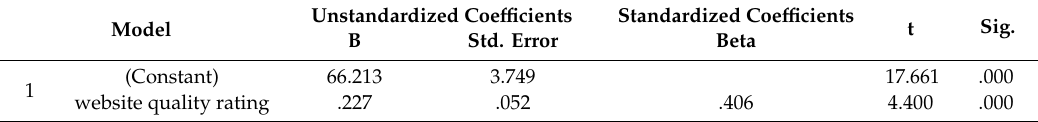
Table 14. Model coe ffi cients simple regression analysis of website quality and SEO